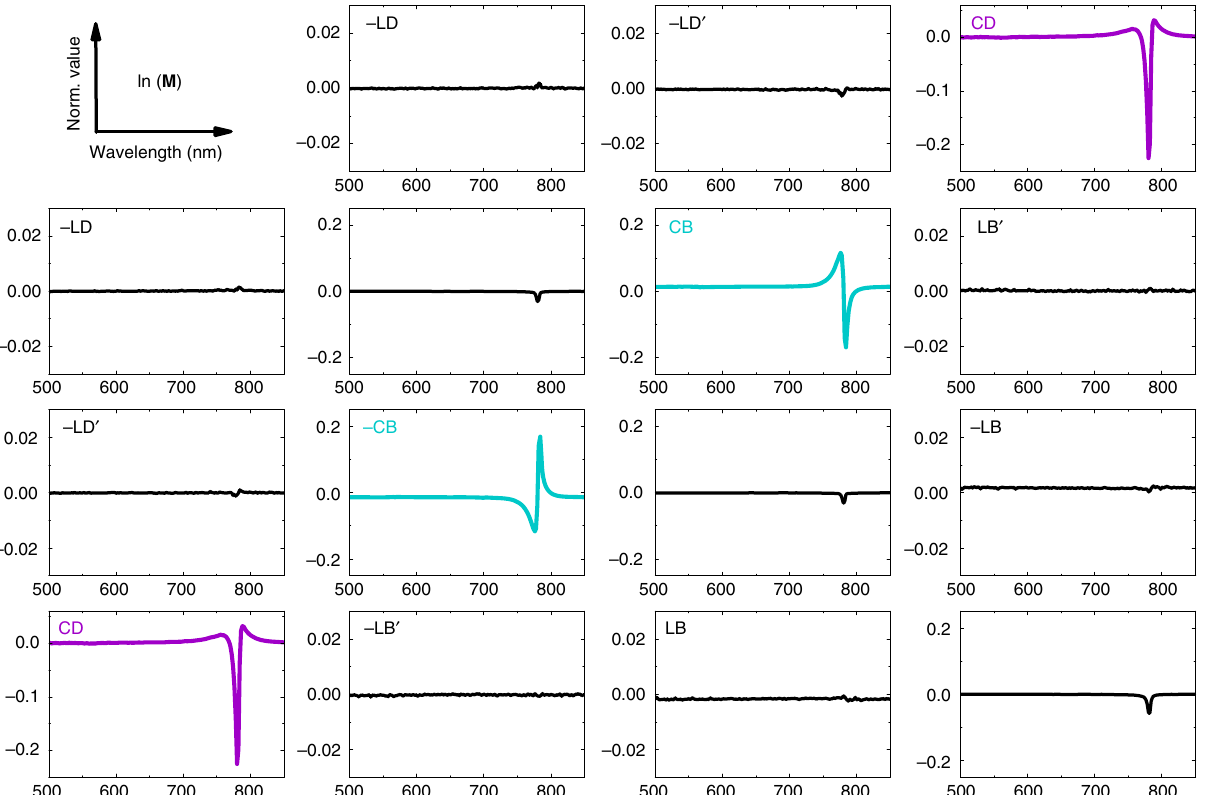
Fig. 5 Mueller matrix spectroscopy. Calculated differential Mueller matrix ( L ) of ( S,S )-ProSQ-C16 annealed at 180 °C with 20 nm fi lm thickness. The assignment of the matrix elements is according to Eq. (1) in units of radian vs. wavelength in nm. The element l 00 equals zero and is omitted. Note that the scaling of the axes for the linear anisotropies is smaller by a factor of